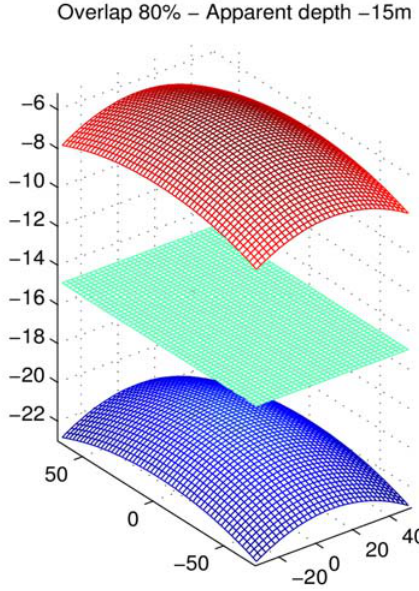
Figure 4. Real ( blue ) and apparent ( green ) sea bottom, with their difference ( red ), based on the Sensfly SwingletCAM scenario, of 100 m flying height and 80% overlap.